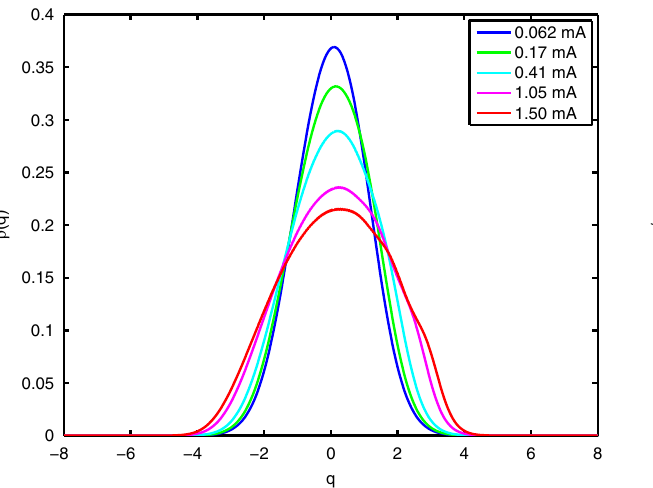
FIG. 2. (Color) A comparison between VFP and PIC codes using the impedance of SLC damping ring [21]. The number of macroparticles is chosen to be the same as the number of grid points in the VFP solver.